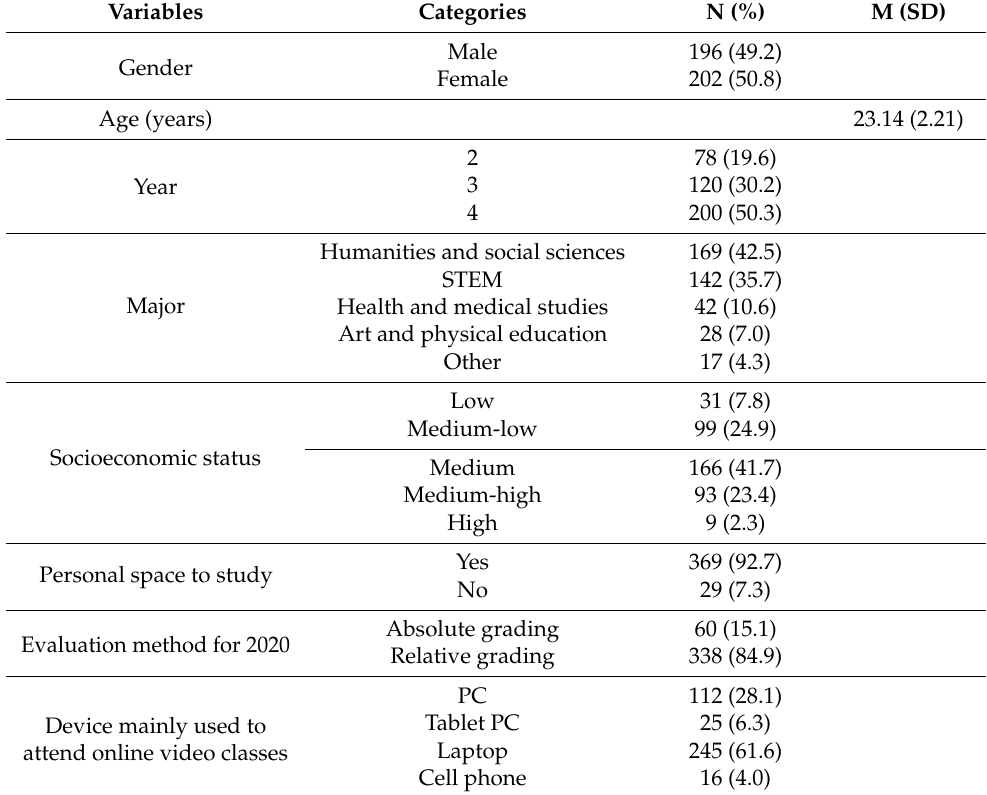
Table 1. General characteristics and characteristics related to the learning